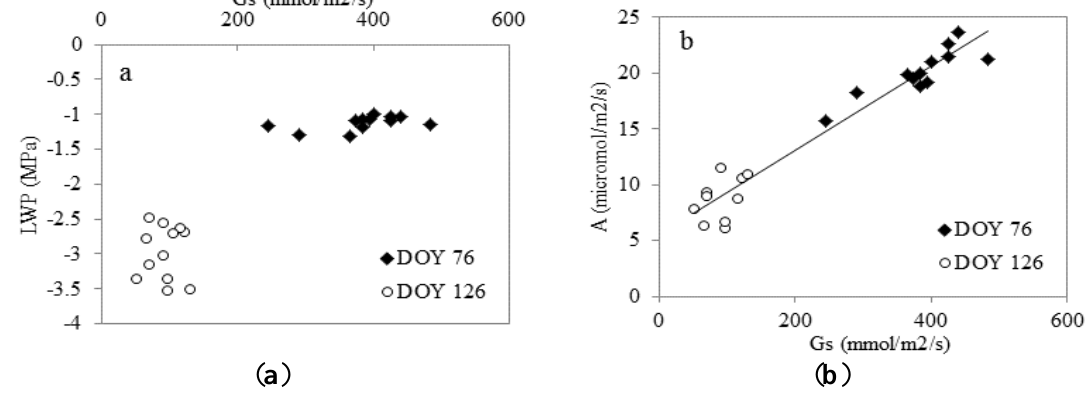
Figure 5. Relationships between stomatal conductance (Gs; mmol·m −2 ·s −1 ) and leaf water potential (LWP; MPa) ( a ); and net assimilation (A; μmol·m −2 ·s −1 ) ( b ) for two selected varieties of bread wheat and two of durum wheat. Each point represented a single plot. A linear regression was fitted to both dates in Figure 5b.